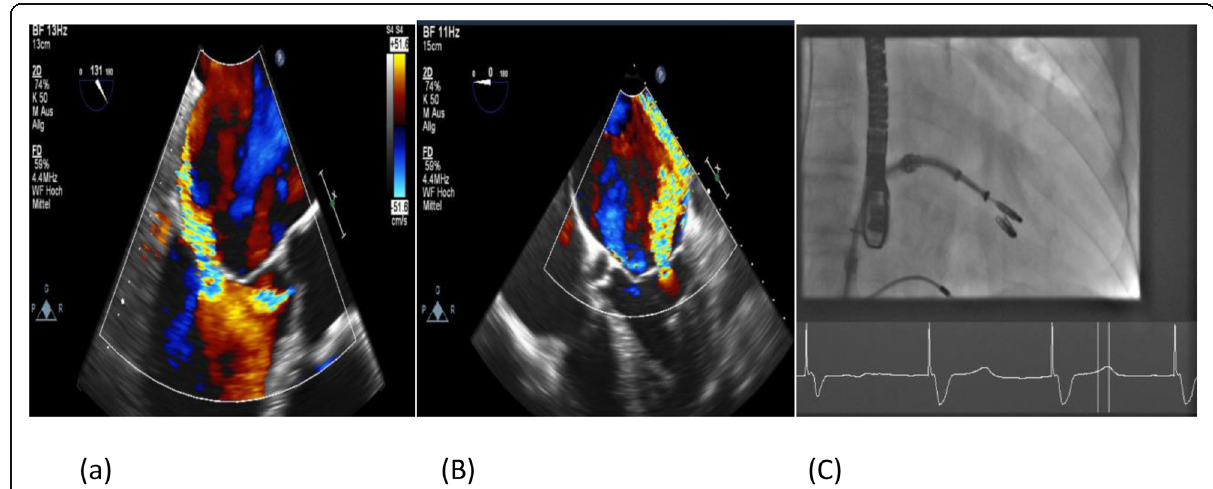
Fig. 4 TEE showing MR with wide VC (9 mm) in 3-chamber ( a ) and 4-chamber ( b ) mid-esophageal view, which was treated with 2 clips ( c